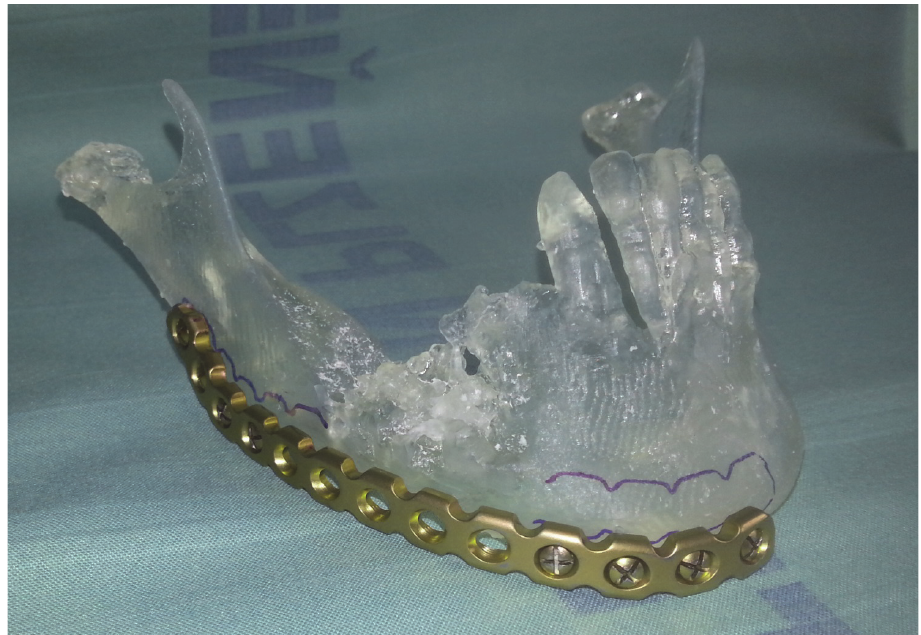
Fig. 4. Reconstruction plate prebended on the patient-specific model of the